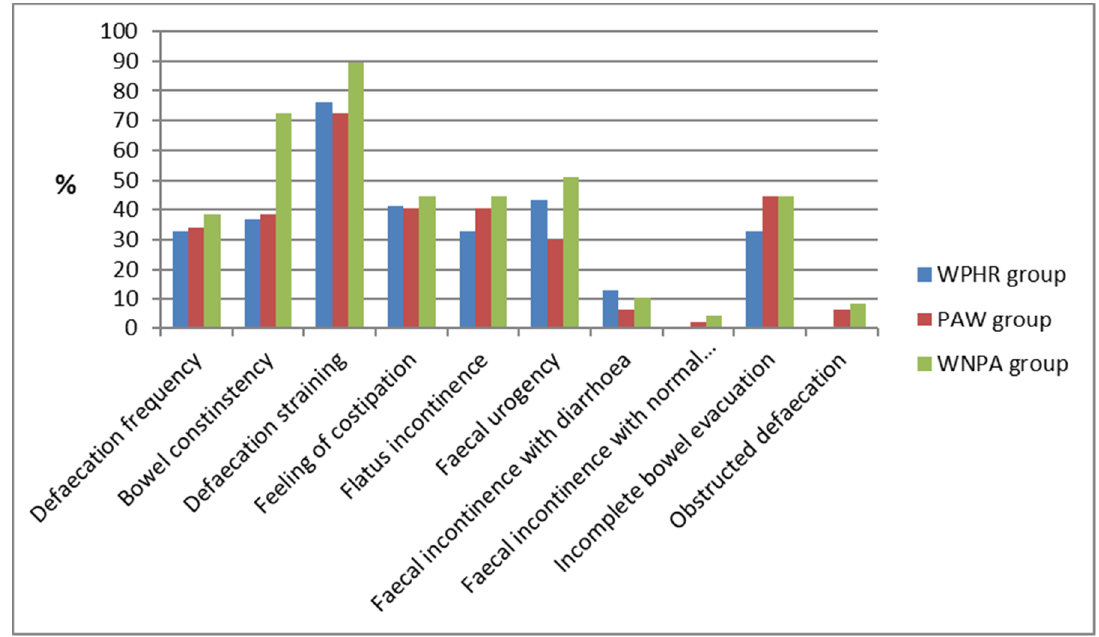
Figure 3. Occurrence of bowel symptoms by groups.